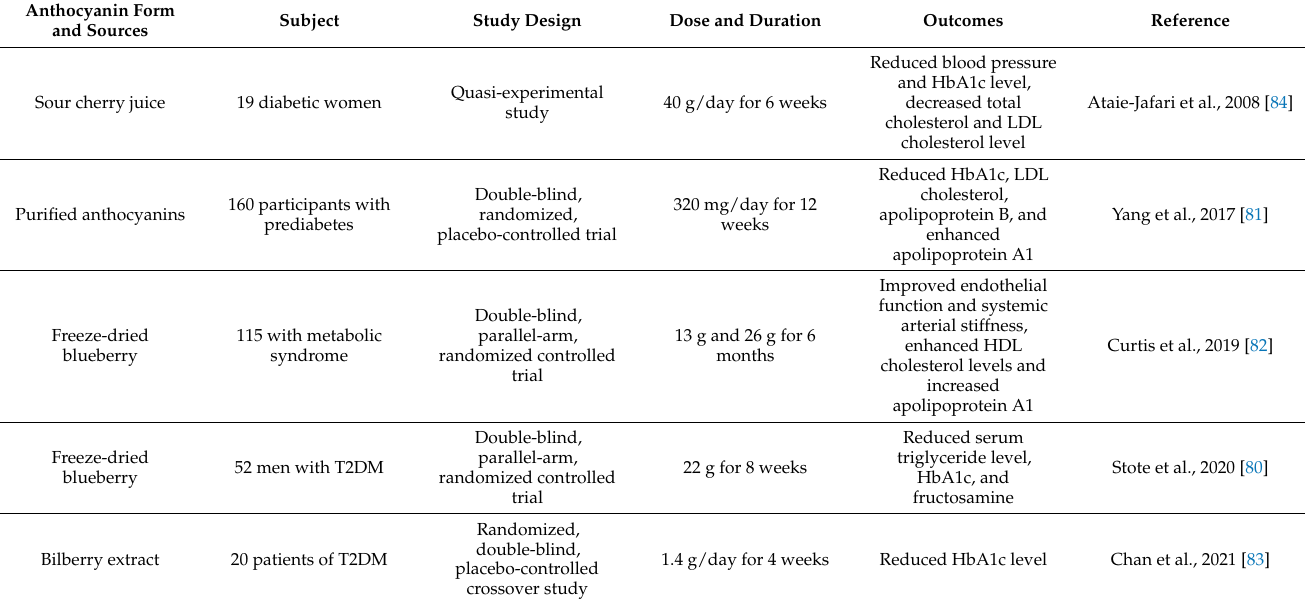
Table 2. Summary of effects of anthocyanin in in clinical studies of diabetic cardiovascular